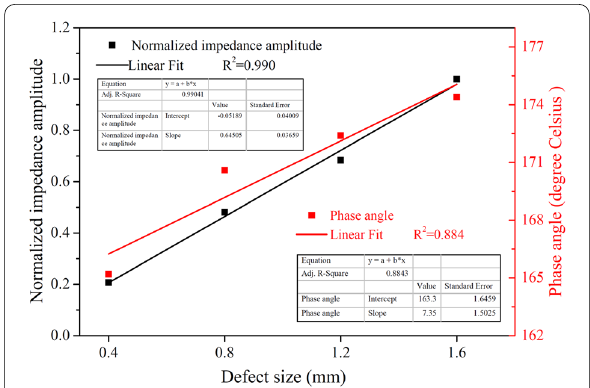
Figure 15 Relationship between defect size and the normalized impedance amplitude and the impedance phase angle of the captured defect EC